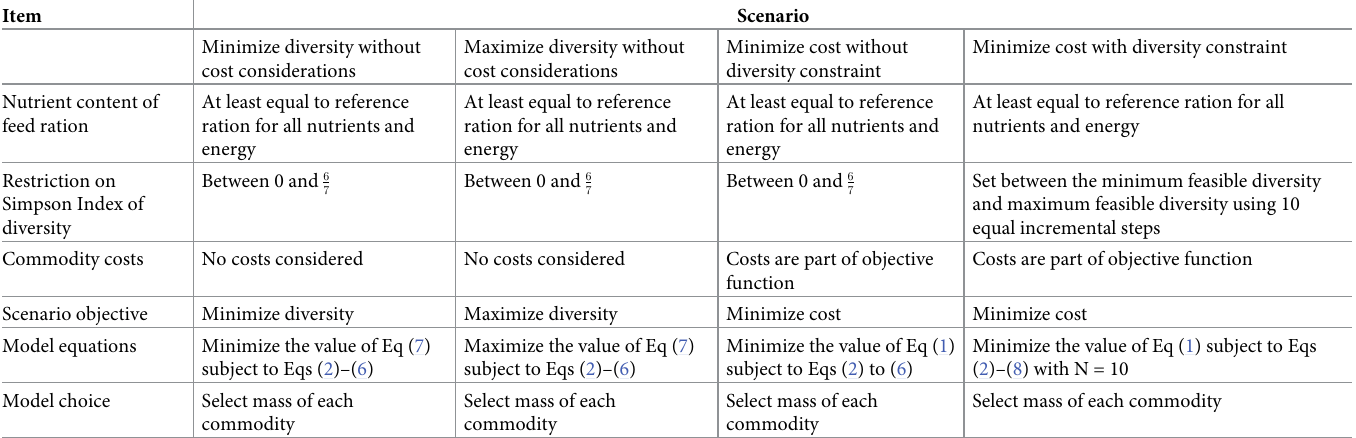
Table 1. Summary of scenarios simulated in each country using the mathematical programming